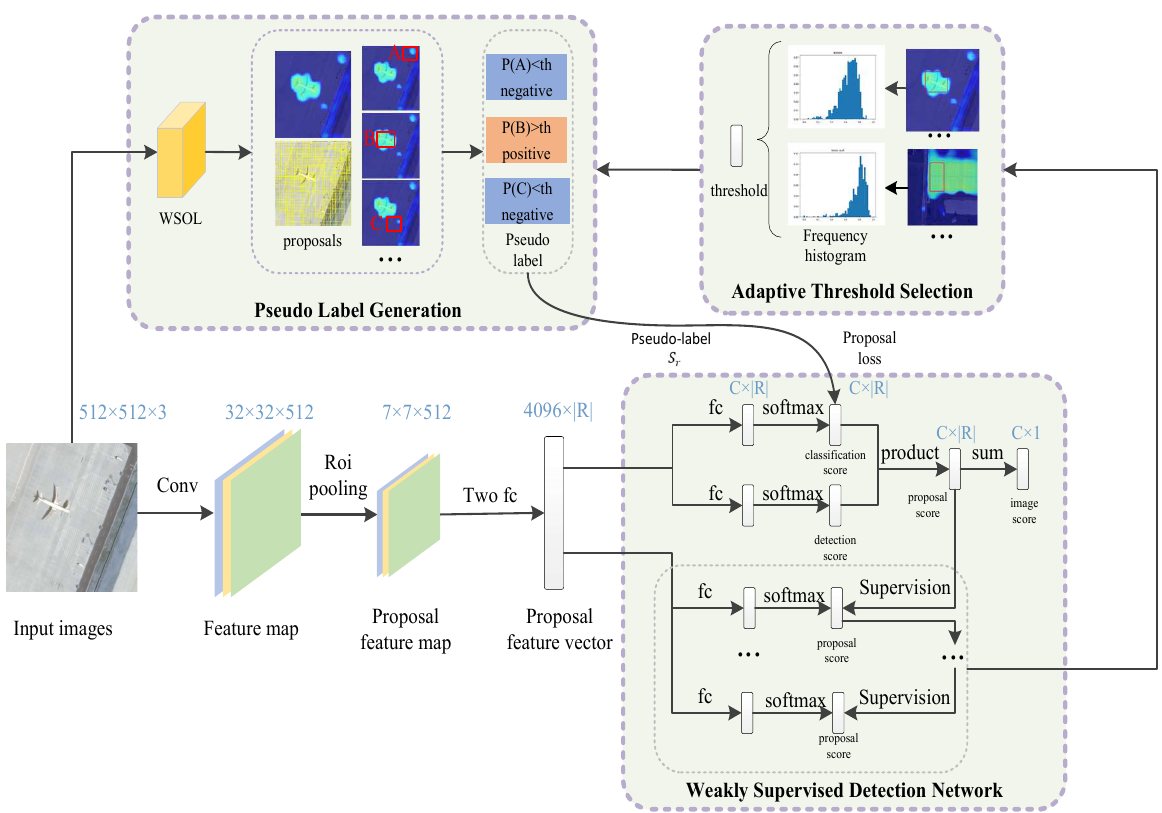
Figure 2. Pipeline of our weakly supervised learning strategy. The pseudo-label generation strategy generates category labels for each proposal during the training phase. The weakly supervised detector combines the proposal pseudo-labels and the image category labels for training. The adaptive threshold selection strategy is used to update the threshold for computing pseudo-labels. In “Weakly Supervised Detection Network”, the ellipses represent the intermediate refinement classifier